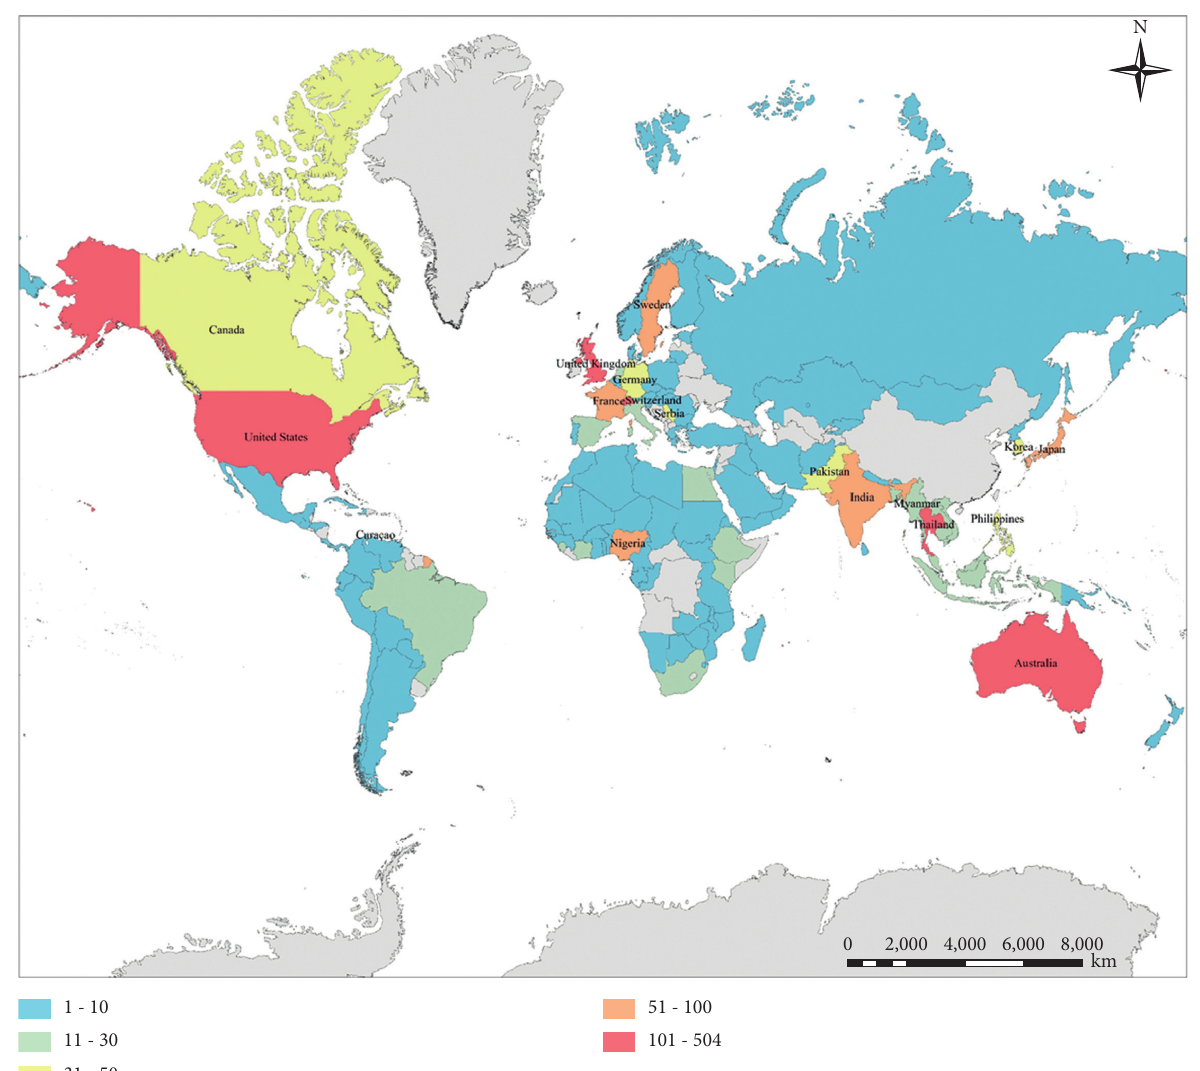
Figure 2: The collaborations of different countries with China. According to the addresses in the article, the number of cooperative publications with China is calculated. Blue represents 1–10 cooperative publications, green represents 11–30 cooperative publications, yellow represents 31–50 cooperative publications, orange represents 51–100 cooperative publications, and red represents 101–504 co- operative